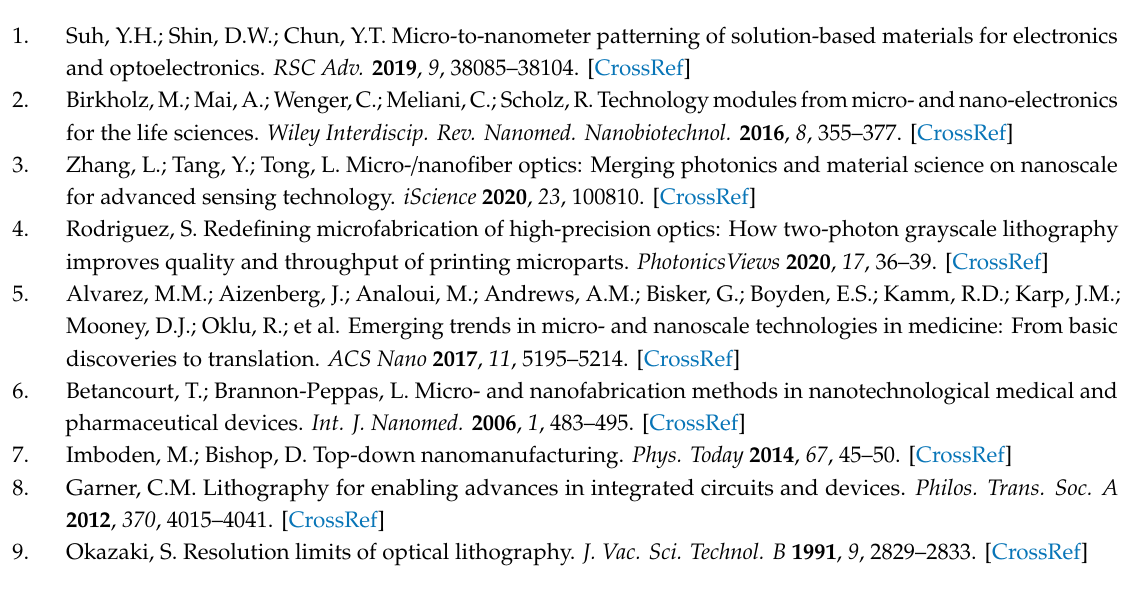
Figure S1: The length-dependent resistance measurements for estimation of the contact resistance; Figure S2: Surface profile of single ( n = 1, top) and double ( n = 2, bottom) DGP overprints; Figure S3: (a) Transfer and (b) output characteristics of bottom contact / bottom gate OFETs with DPP-DTT as active layer, comprising thermally evaporated Ag electrodes. V SD = − 40 V for transfer characteristics; Figure S4: Output characteristics of bottom contact / bottom gate OFETs with DPP-DTT as active layer, comprising single ( n = 1), double ( n = 2) and triple ( n = 3) overprints as